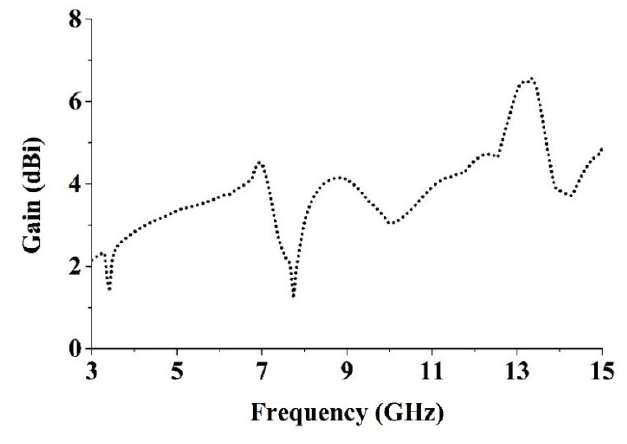
Figure 18. The measured peak gain of the proposed UWB MTM antenna.